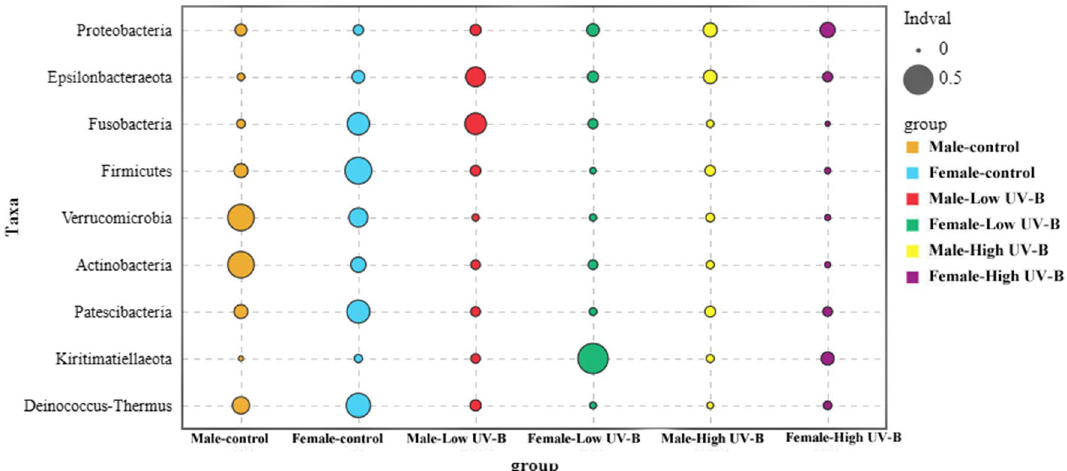
Figure 8. Indicator species ( P < 0.05) at the phylum level under increased UV-B radiation.